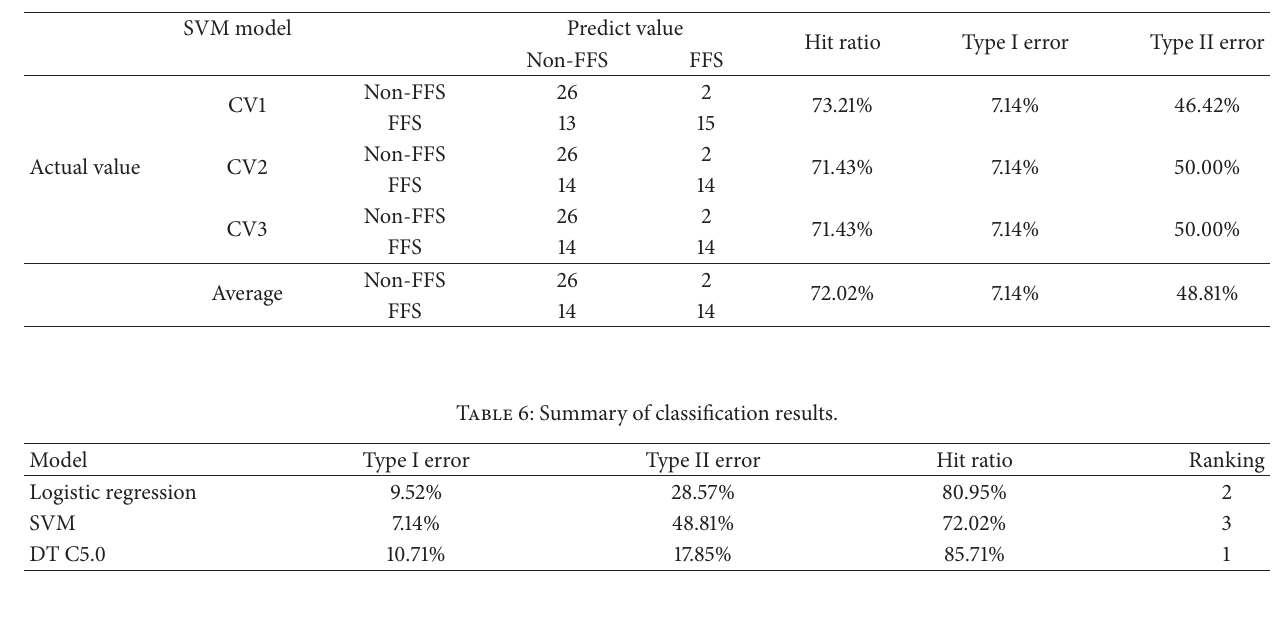
Table 5: SVM cross-validation results.